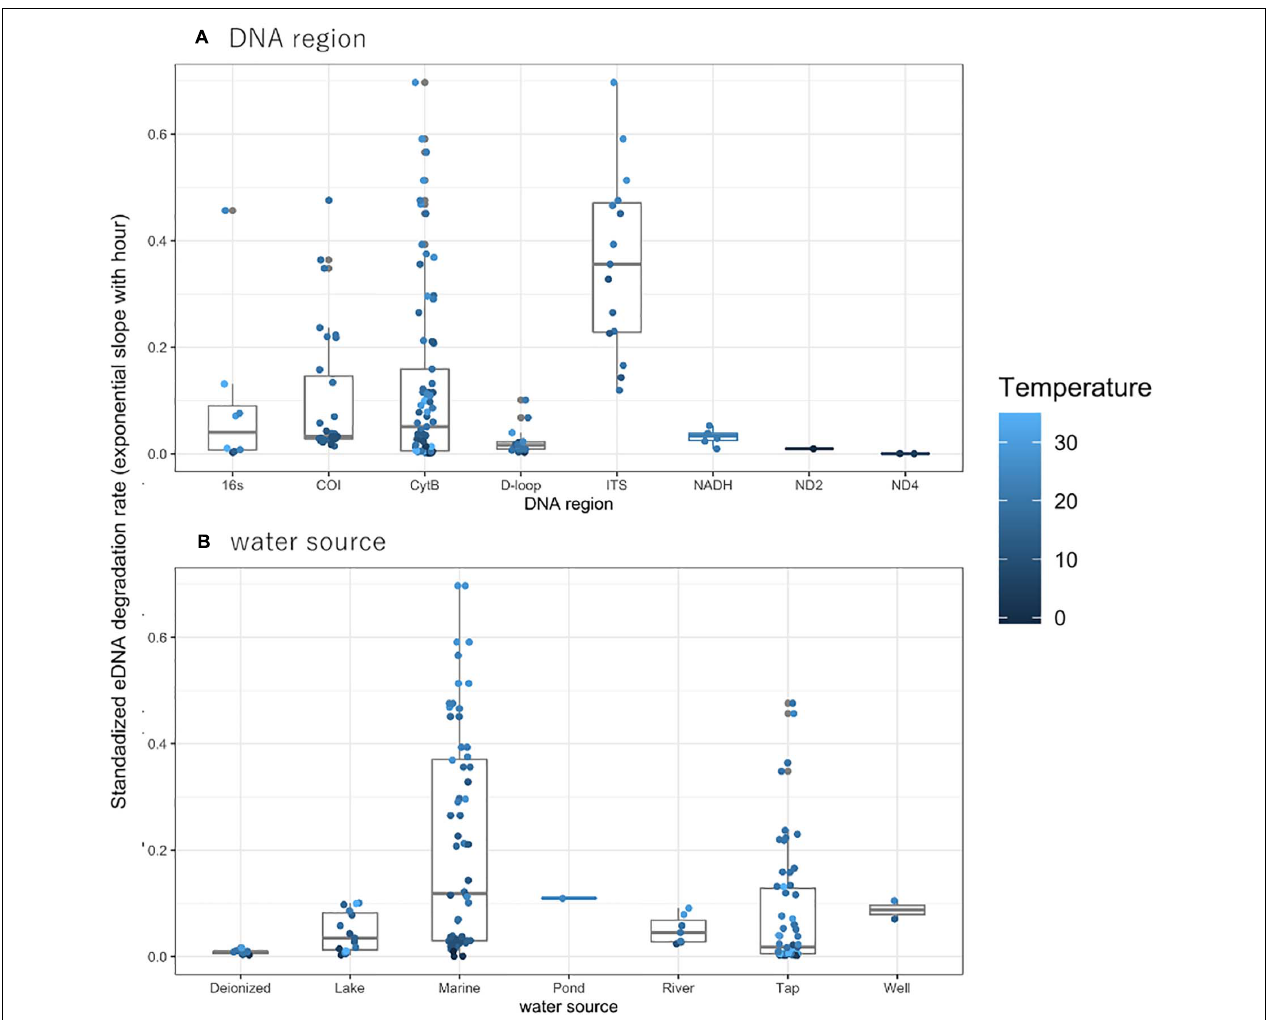
FIGURE 1 | The eDNA degradation rate (simple exponential slope) with (A) DNA region and (B) water source. The degradation rate without temperature data in the experiment were excluded in the plot. The dots indicate the individual eDNA degradation rate in each experiment in different ecosystems. The boxes and bars in the box plot indicate median ± inter-quartiles and ± 1.5 × inter-quartiles, respectively.